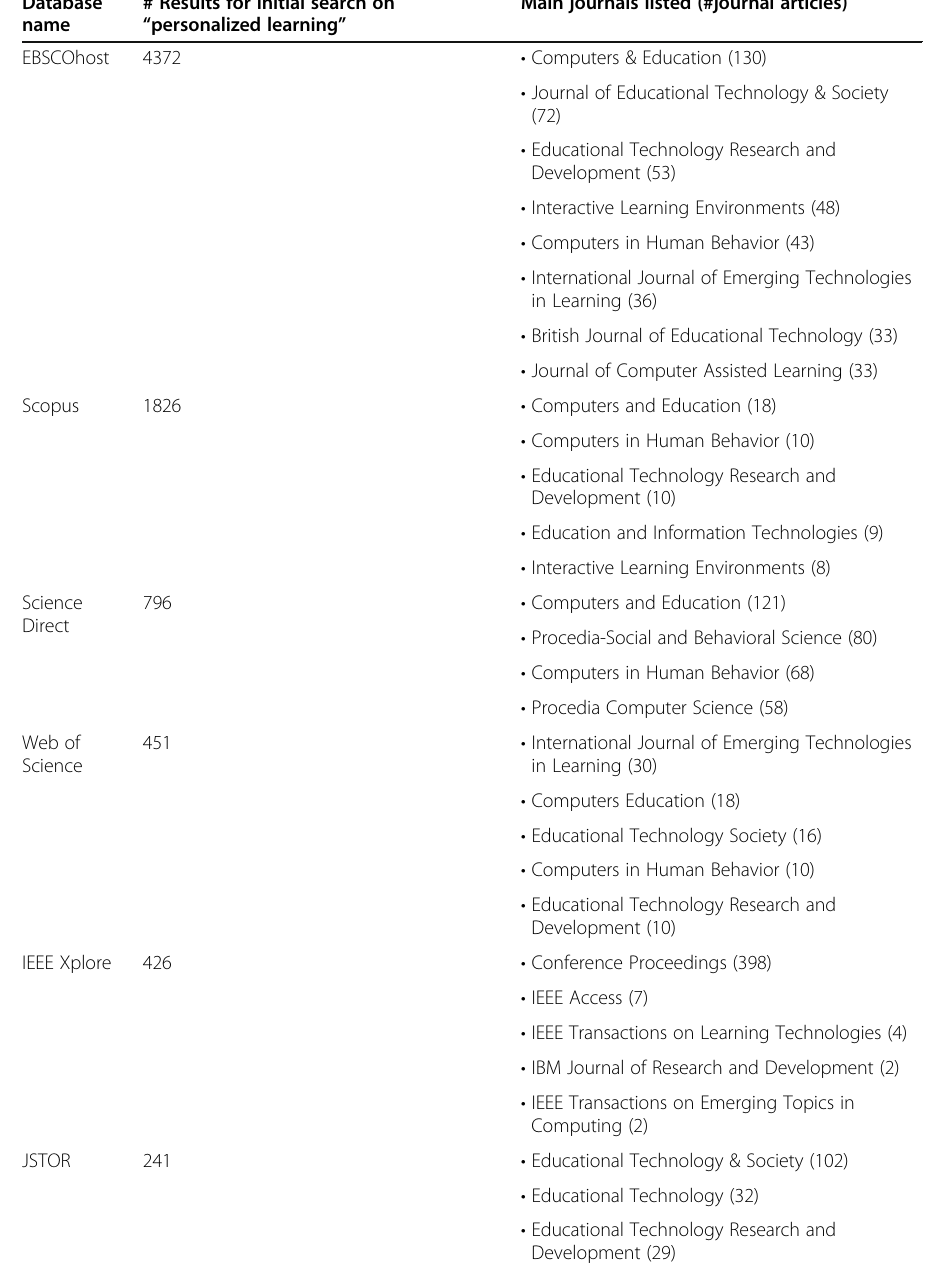
Table 1 The search results for “ personalized learning ” for selected databases Database